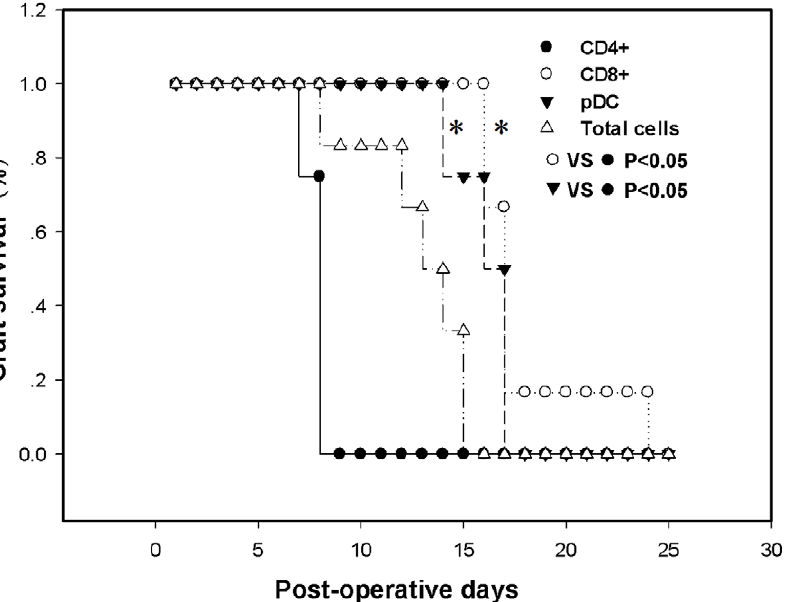
Figure 5. CD8 + T cells and pDCs play a dominant role to promote allograft long-term survival. The purified CD4 + T cells (5 6 10 6 ), CD8 + T cells (5 6 10 6 ), pDCs (5 6 10 5 ) and total splenotytes (5 6 10 6 ) originated from recipients with long-term allograft survival were then adoptively transferred into naive recipients respectively. One day after the adoptive transfer, the mice were transplanted with cardiac allograft. The survival time of cardiac allografts was monitored. The data shown are representative of three independent experiments (*P ,